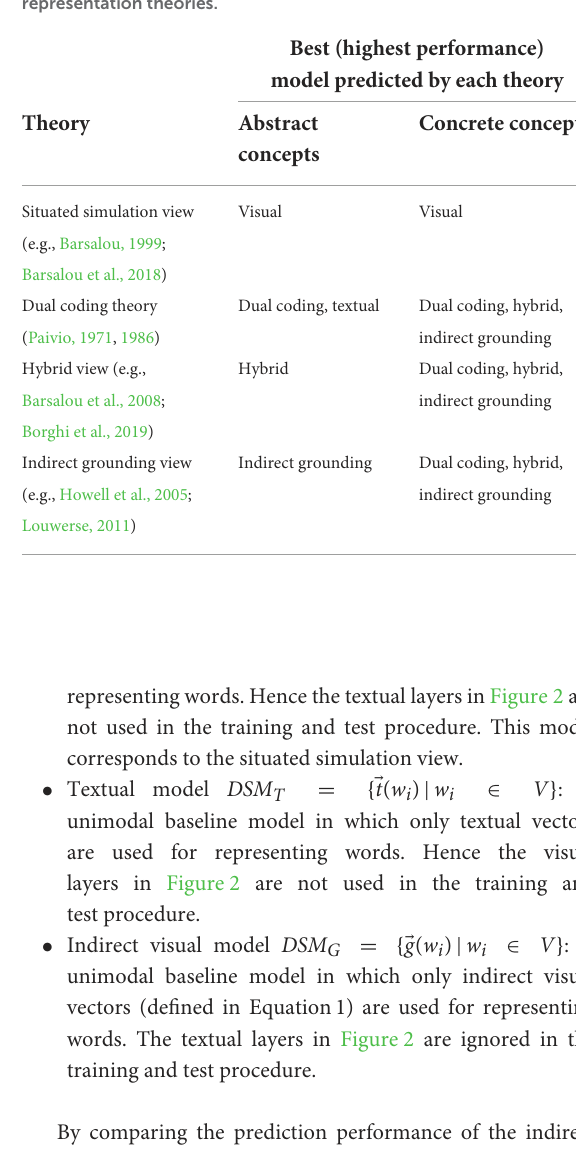
TABLE 2 Predictions of evaluation performance by conceptual representation theories.